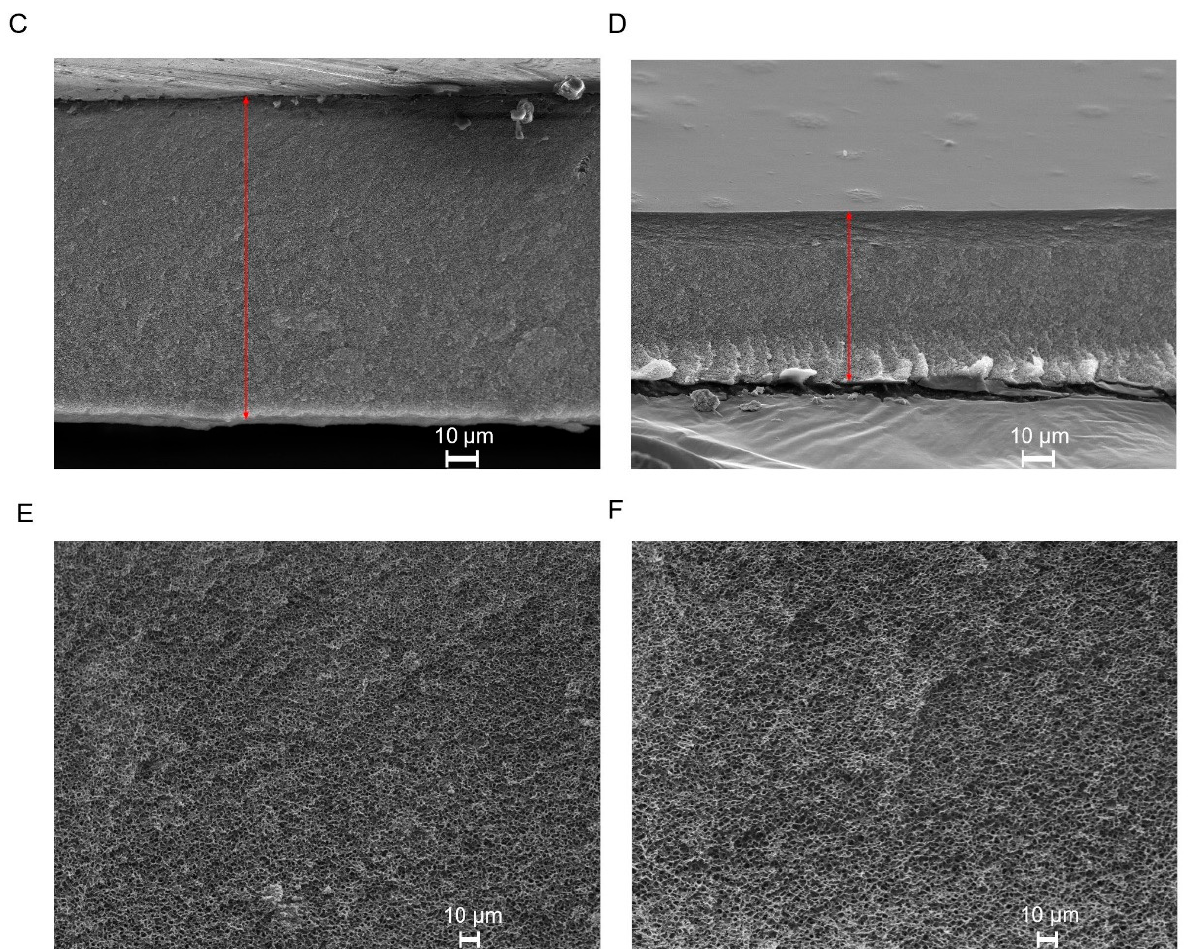
Figure 4. SEM images of the CA-SiO 2 -(CH 2 ) 3 NH 2 ( A , C , E ) and CA ( B , D , F ) membranes. ( A , B ): top active layer (1000 × ). ( C , D ): cross-section (700 × ) where the red lines indicate the membranes’ thickness. ( E , F ): bottom porous surface (4000 × ).